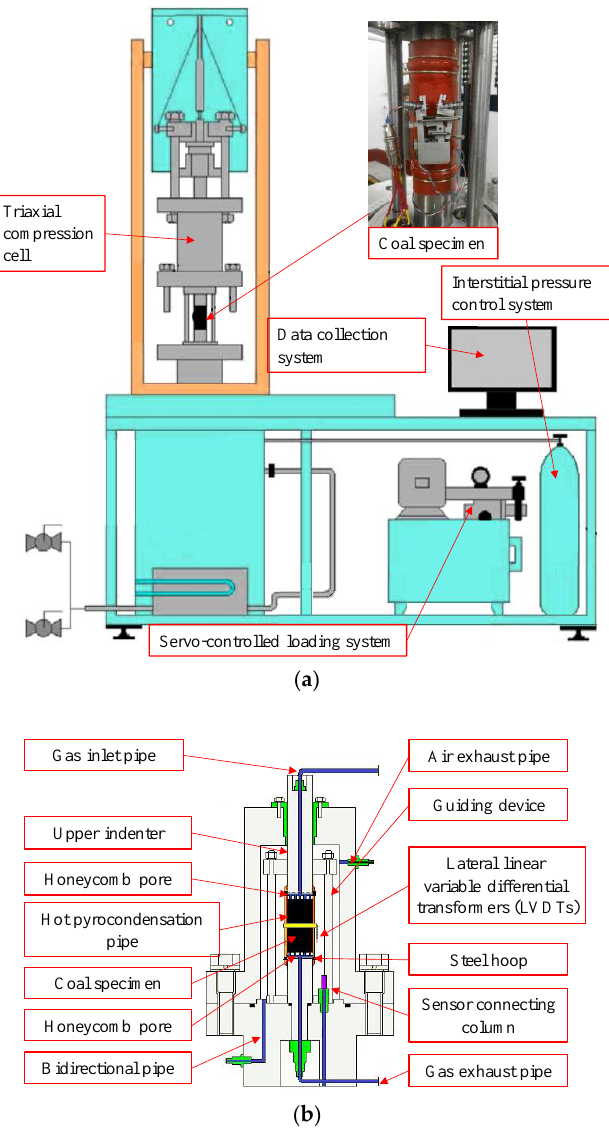
Figure 1. Triaxial seepage experimental device for the measurement of the heat–fluid–solid coupling property of gas-containing coal and the experimental chamber: ( a ) The whole experimental device and ( b ) the experimental chamber.